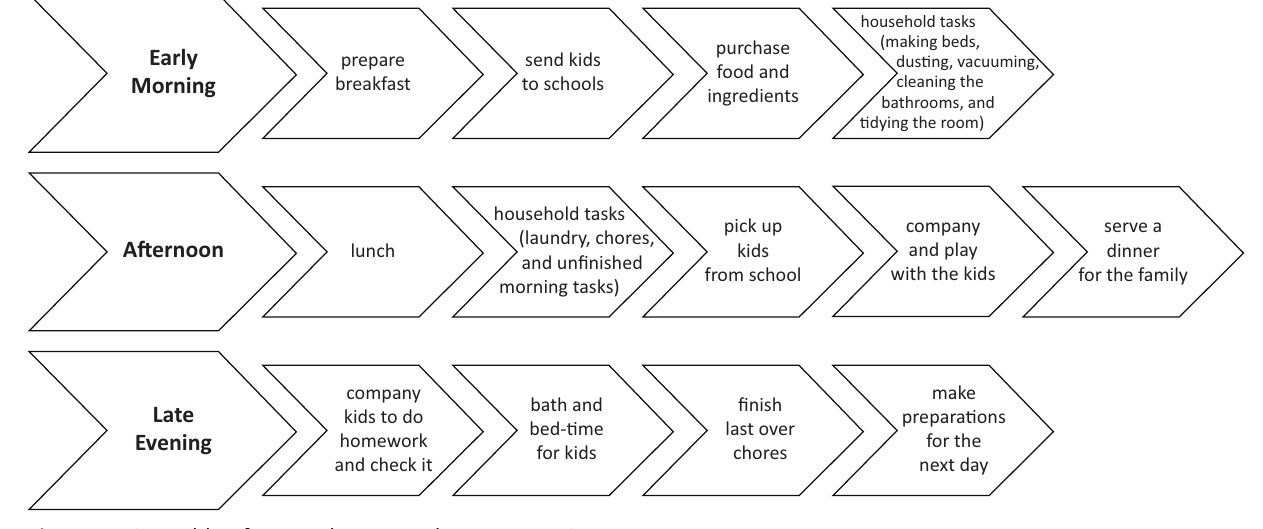
Figure 4. Timetable of stay‐at‐home mothers on Douyin.